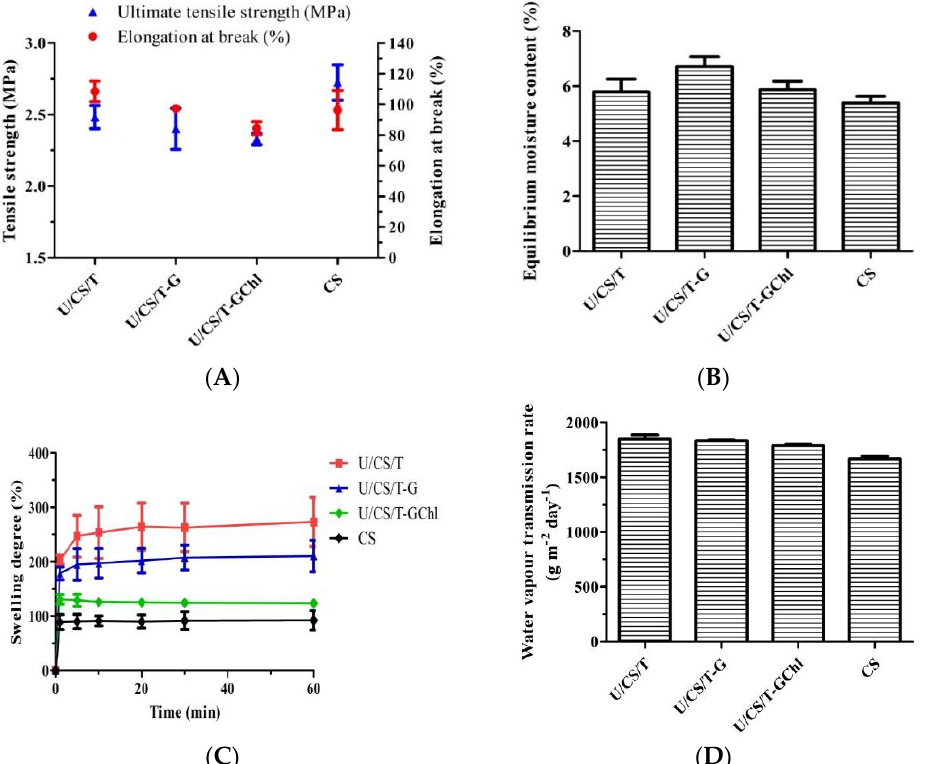
Figure 1. Several physical properties of the chitosan and ulvan/chitosan complex films: ( A ) ultimate tensile strength and elongation at break, ( B ) equilibrium moisture content, ( C ) swelling degree, and ( D ) water vapor transmission rate. All the complex films had the same composition of U/CS/T at 20/75/5. Data were represented by the mean ± SD, n = 3.